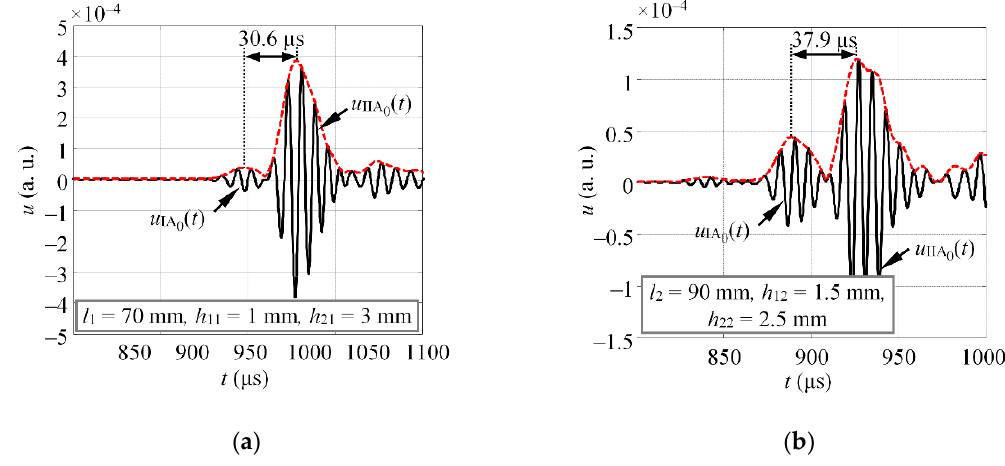
Figure 14. The vertical component of the particle velocity at nodal point r 2 for sample No. 1 ( a ) and sample No. 2 ( b ) showing the converted and direct A 0 modes along with estimated delay values.